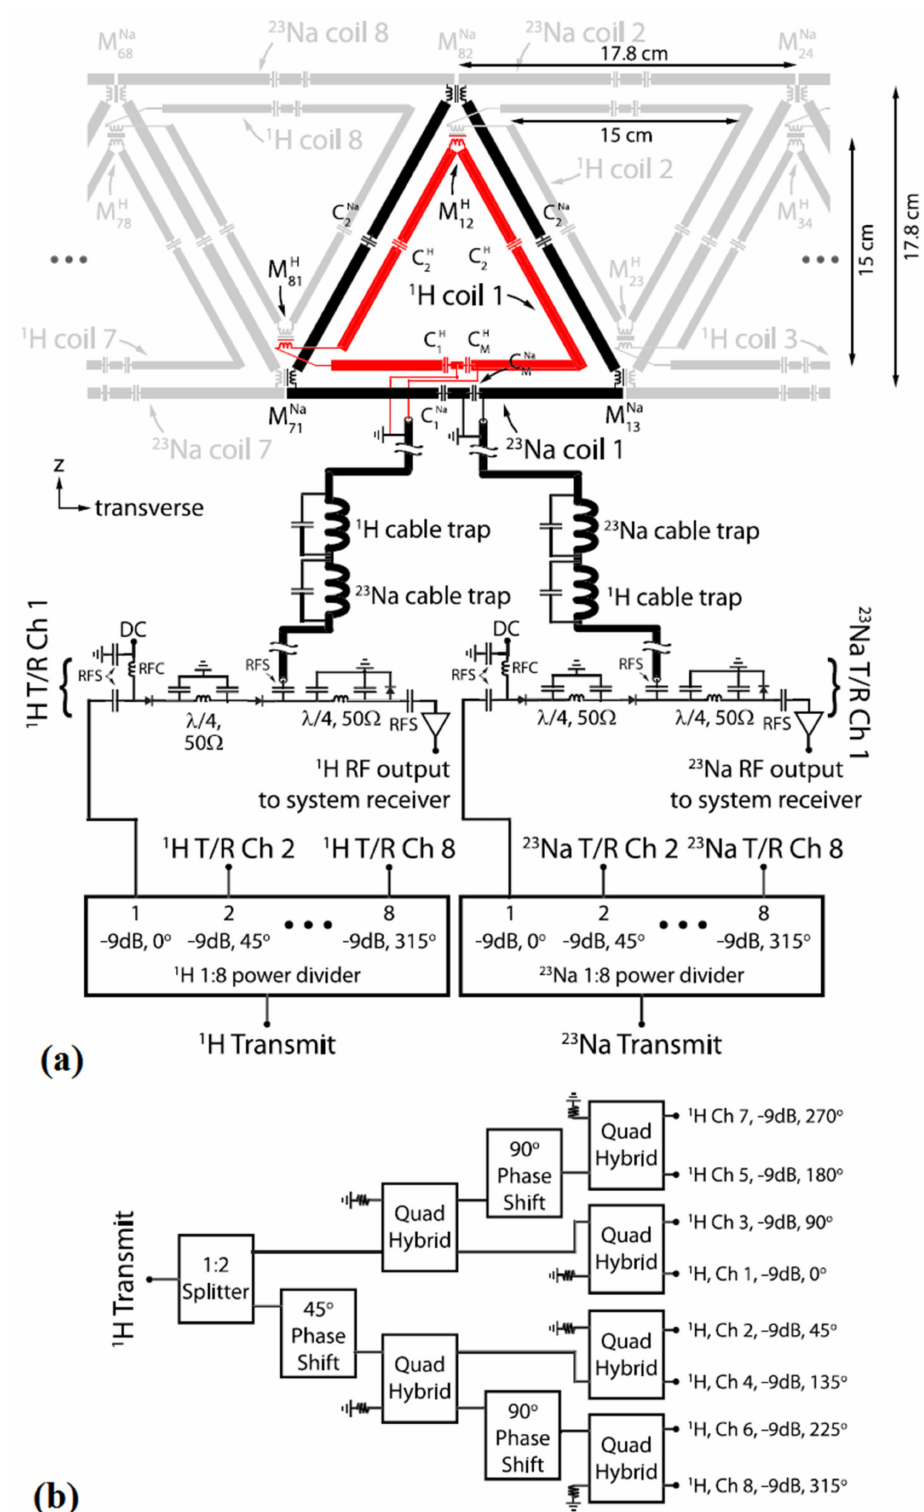
Figure 14. ( a ) Flattened two-dimensional schematic diagram of the eight-channel sodium/hydrogen coil array and interface, in which a single sodium (black) and hydrogen coil (red) are highlighted; ( b ) block diagram of the hydrogen power divider. Reprinted by permission from Lakshmanan et al., NMR in Biomed 2017